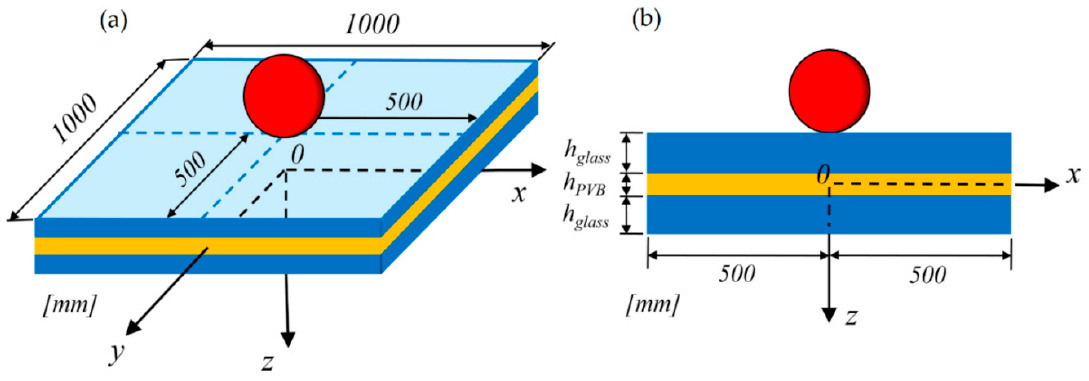
Figure 5. Schematic view of laminated glass under impact of a rigid spherical projectile: ( a ) three- dimensional view; ( b ) front view.